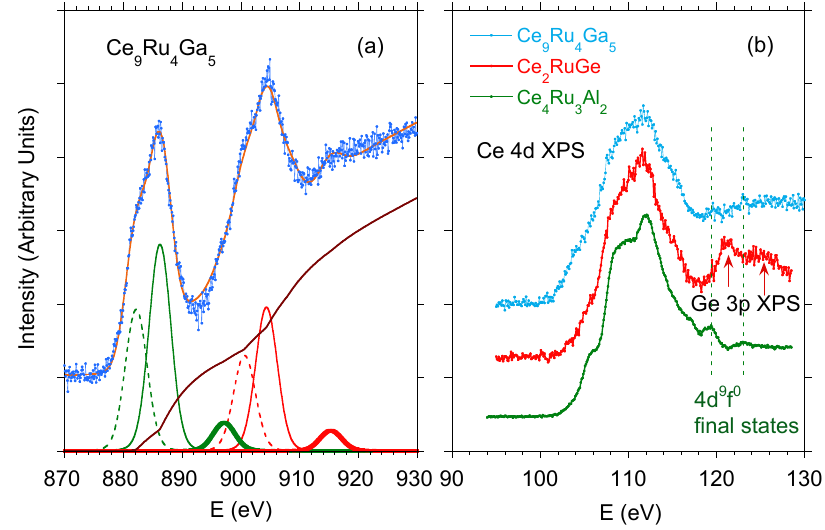
Ru Ga (blue points) and its GS 9 5 4 4 f n and 3 d 9 4 f n (with n = 0, 1, and 2) are presented in 5/2 3/2 Ru Ga compared with the 9 5 4 RuGe [26] and Ce Ru Al (unpublished). 2 3 2 4